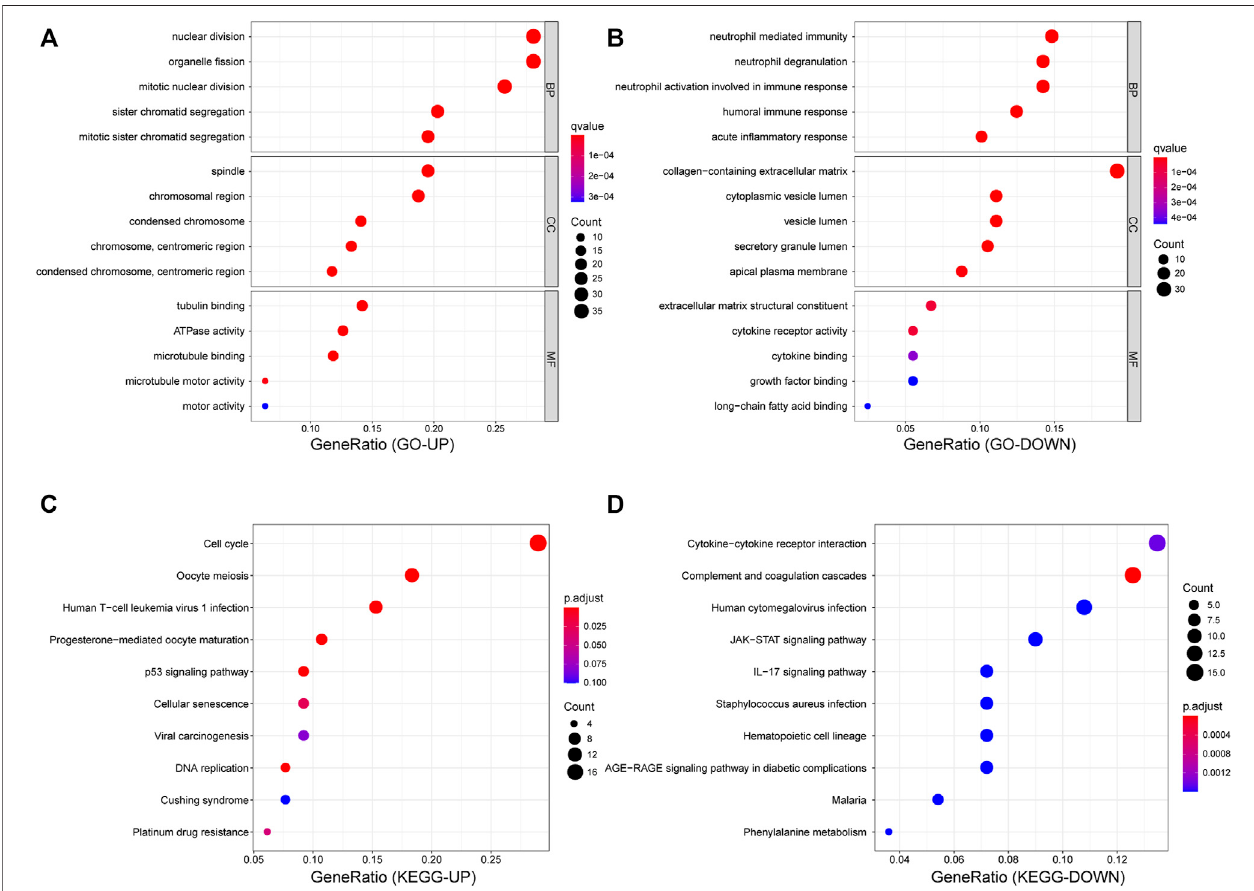
FIGURE 3 | Functional enrichment analyses for DEGs. (A,B) Dot plot of GO enrichment analysis of up- and down- regulated genes. (C,D) Dot plot of KEGG enrichment analysis of up- and down-regulated genes.